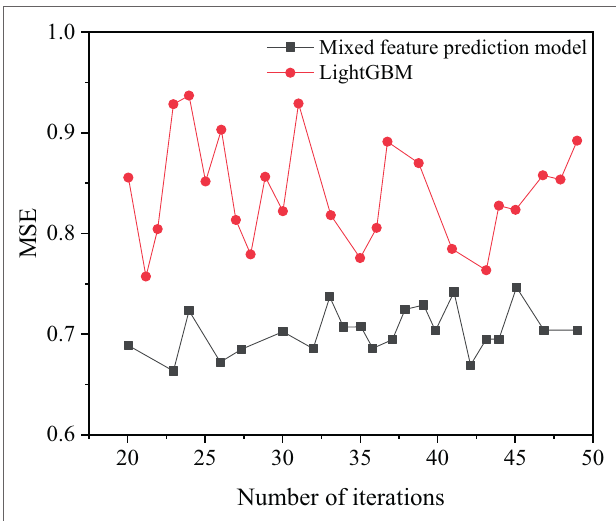
FIGURE 13 | MSE results compared with LightGBM.